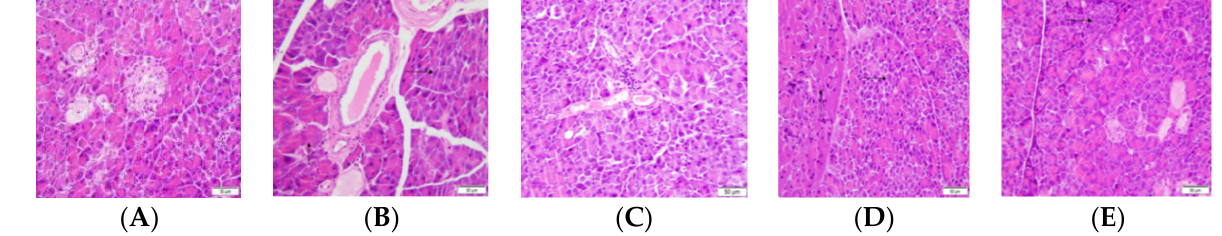
Figure 8. Effect of PPPT on pancreatic tissue morphology of type II diabetes mice (HE. × 400): ( A ) normal group; ( B ) model group; ( C ) metformin; ( D ) PPPT-4 group; ( E ) PPPT-1 group.